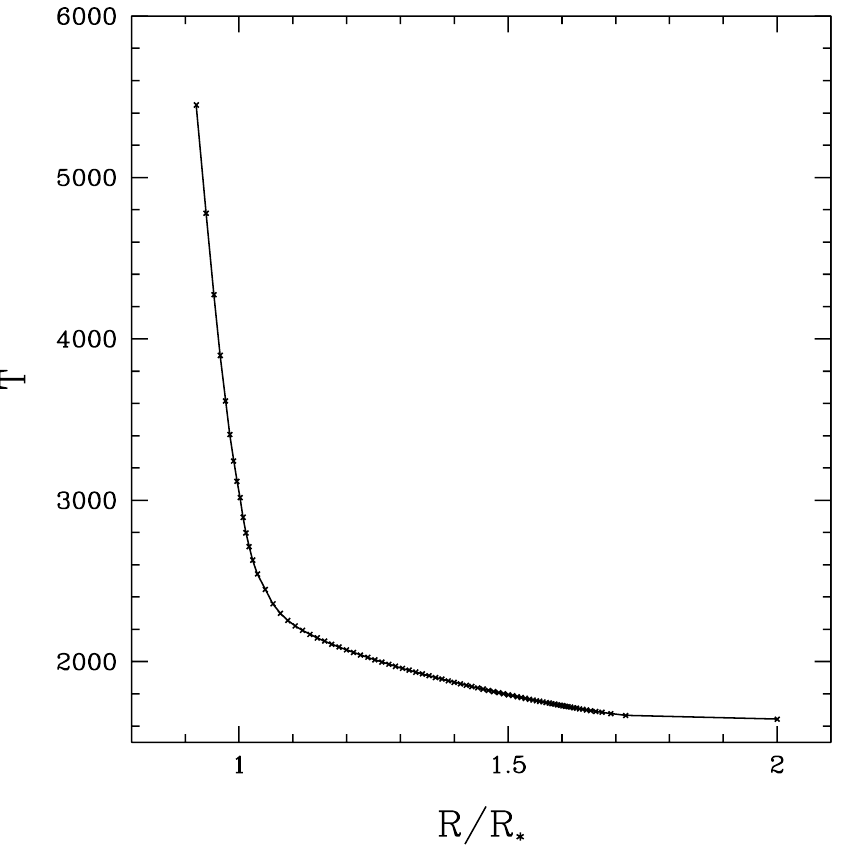
Figure 1. Temperature profile as a function of the radius of the initial hydrostatic model (R ∗ = 270 R (cid:12)